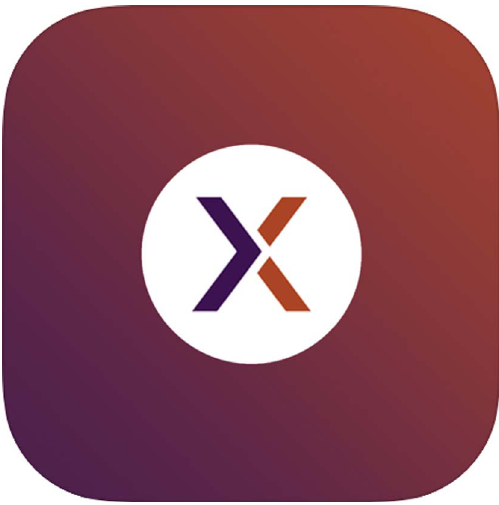
Figure 4. Exogen connects app